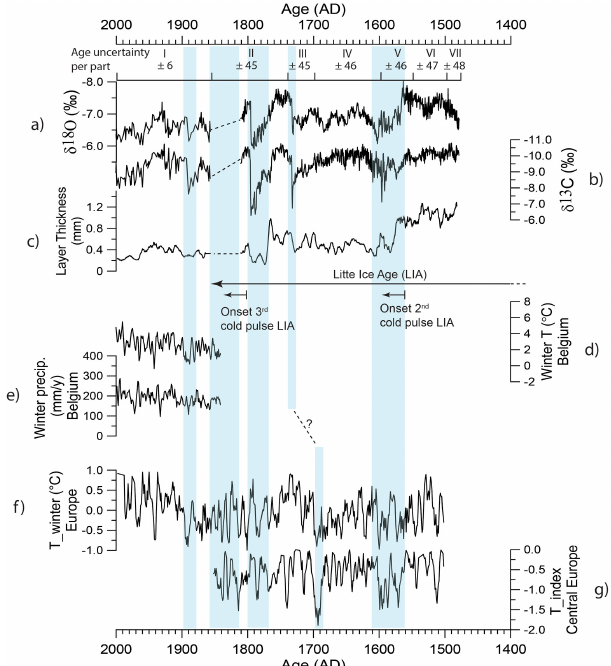
Figure 5. (a) δ 18 O and (b) δ 13 C values (‰ VPDB) and (c) layer thickness plotted against (d) the instrumental winter temperature (DJF) and (e) winter precipitation (DJF) record of the Belgian Royal Meteorological Institute (RMI) measured in Brussels since 1833, (f) the winter temperature reconstruction based on multiple prox- ies in Europe (Luterbacher et al., 2004) and (g) the winter tem- perature reconstruction derived from documentary and instrumen- tal evidence in central Europe (Dobrovolny et al., 2010). Five ex- ceptionally dry (and cold) winter periods suggested by the Proser- pine are indicated by blue bars and correspond to clear cold periods in instrumental records and winter temperature reconstructions in Europe and central Europe. Two periods of relatively wetter (and warmer) winters occur from 1479 and 1565 and from 1730 to 1770 and correspond to known warmer intervals. Between 1610 and 1730 the Proserpine suggests relatively drier (and colder) winter periods, which correspond to colder winter conditions in Europe and central